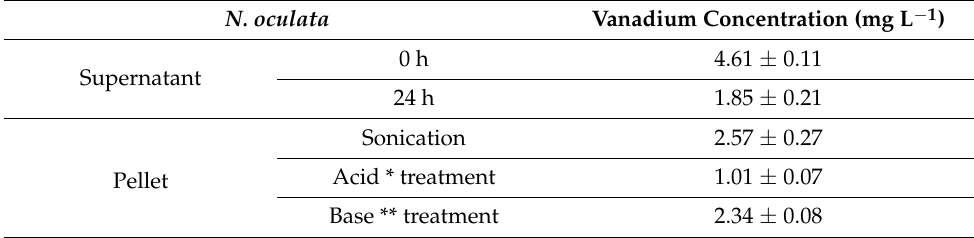
Table 2. Vanadium concentrations of supernatant and pellet under various methods.